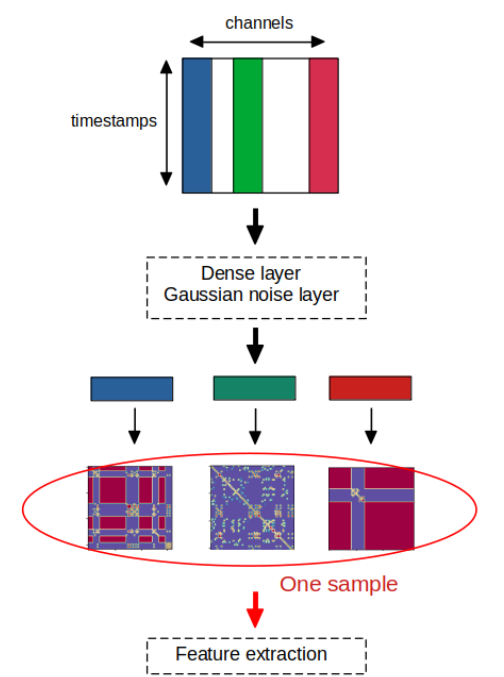
Figure 9. Illustration of section (a) RP generation of the RPCNN model (c.f. Figure 6). The recurrence plots are produced internally by a custom “Recurrence Plot layer” in the model. This approach allows the setting of trainable (cid:101) parameters and generate recur- rence plots on the fly, which eases deployment of the trained models as the recurrence plots do not have to be generated and stored explicitly during preprocessing. For each feature a recurrence plot is drawn and the respective (cid:101) parameters are initialized with random numbers in the interval [ 0, 1 ] . Examples of recurrence plots of an interlock sample and a stable sample are given in Appendix B, where each sample contains 20 plots